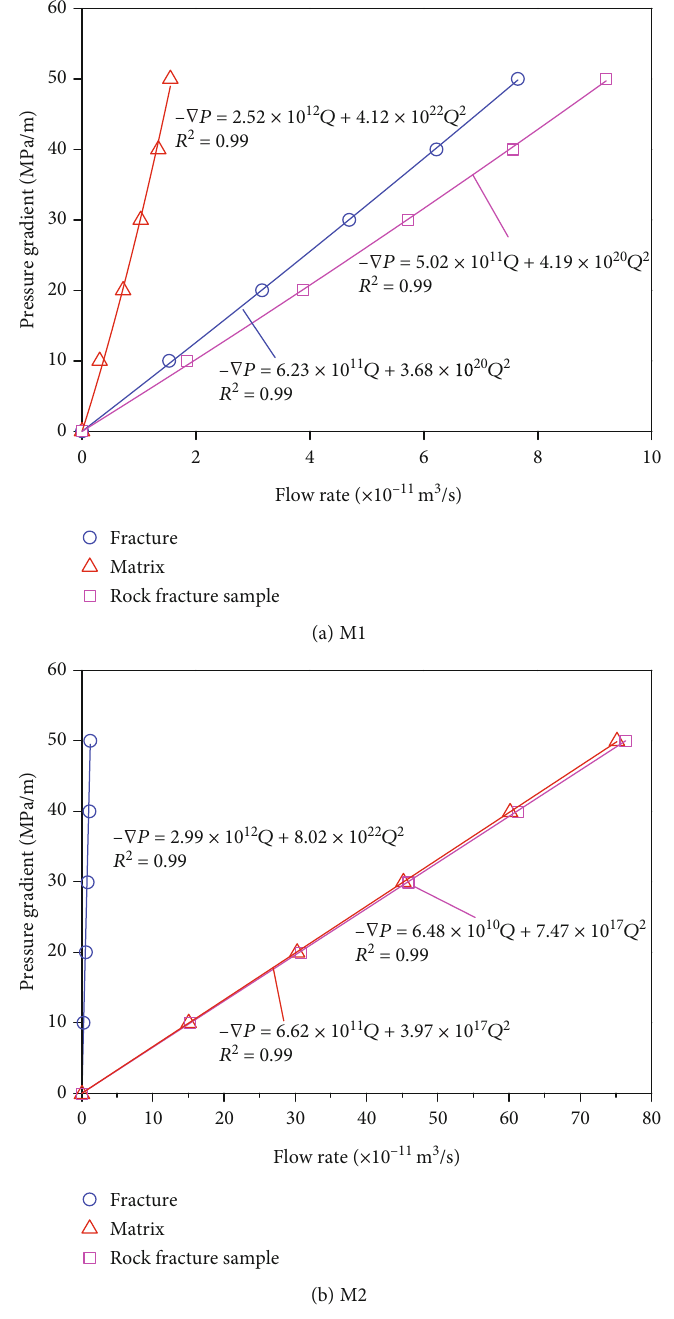
Figure 16: Relations between pressure gradient and the volume fl ow rate of the